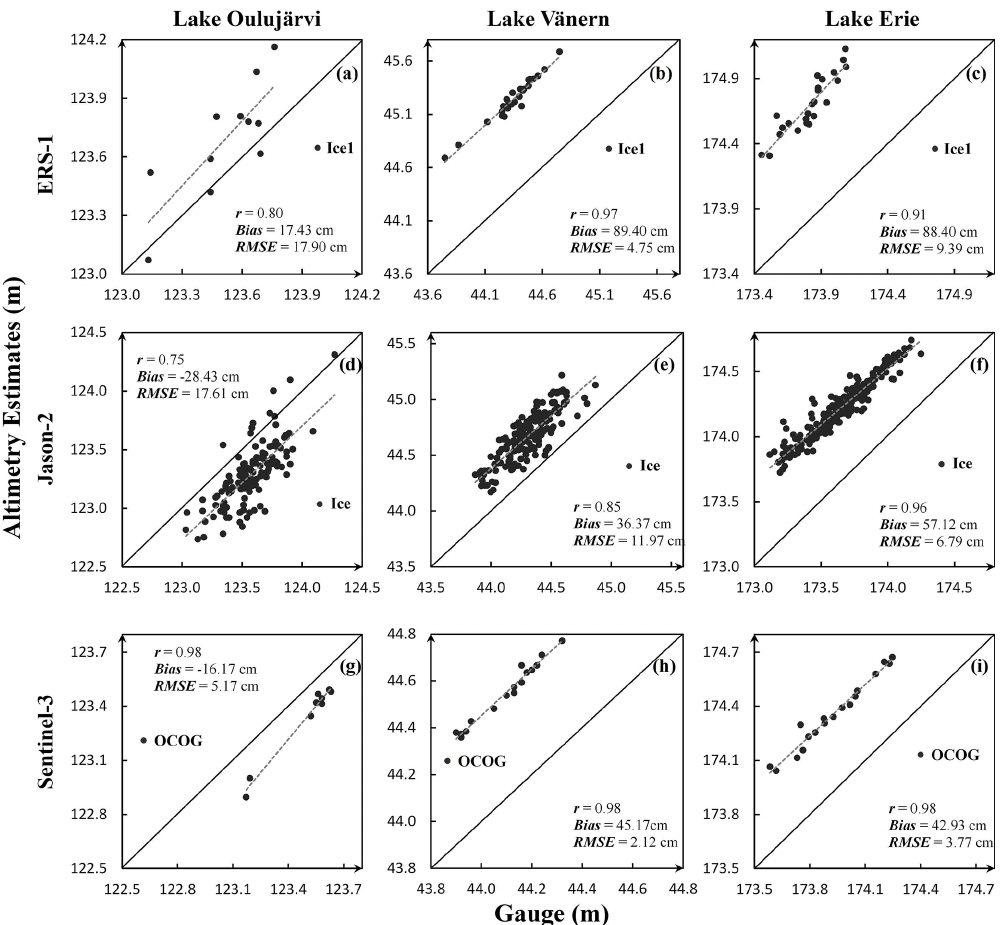
Figure 5. Scatterplots of lake water level estimates given by model-free retrackers against gauge measurements. The scatterplots of the same mission are arranged in the same row, and the scatterplots of the same lake are arranged in the same